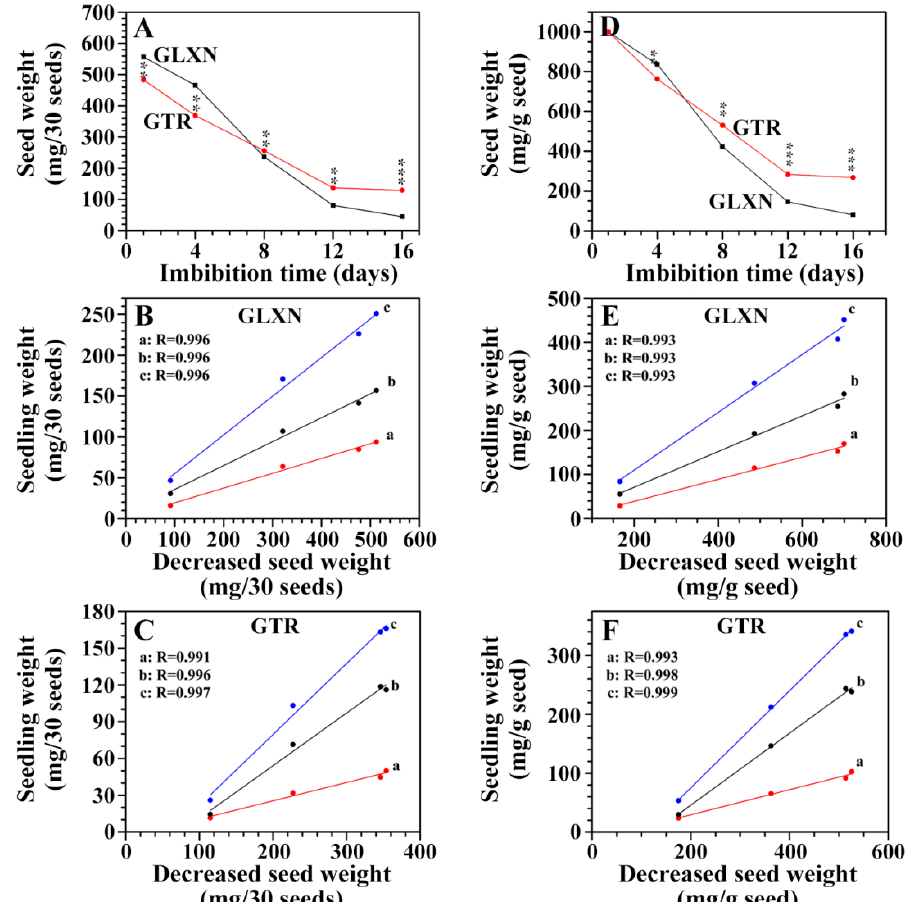
Figure 4. The seed weight and its relationship with seedling weight during seedling growth. ( A , D ): dry weight of seed without the embryo. The values are means ± SD ( n = 3). * The GTR data are significantly different compared with the GLXN data at the same imbibition time (** for p < 0.01 and *** for p < 0.001). ( B , C , E , F ): the relationships between the decreased seed weight and root dry weight (a), shoot dry weight (b), and seedling dry weight (root weight + shoot weight) (c). The R indicates the regression coefficient.